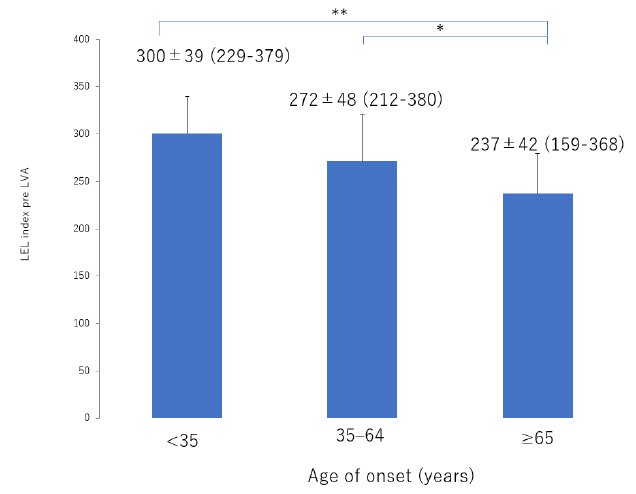
Figure 5. LEL index score before LVA according to age of onset. There was statistically significant deterioration in score with age of onset from the ≥65 group, 35–64 group, through to the <35 group. LEL, lower extremity lymphedema; LVA, lymphaticovenous anastomosis * p < 0.05, ** p < 0.01 (Tukey–Kramer test).